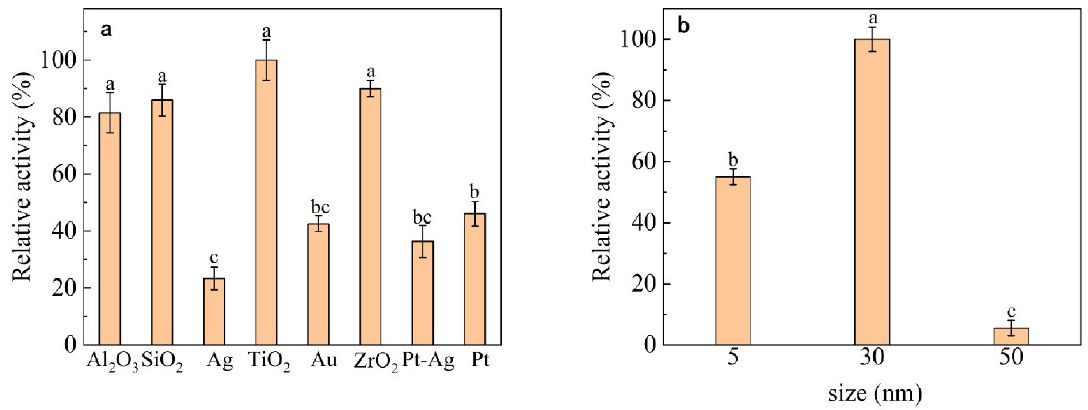
Figure 1. Nanomaterial selection: ( a ) different nanomaterials; ( b ) different particle sizes of TiO 2 . On the bar chart, the different lowercase letters show that there are significant difference ( p > 0.05).